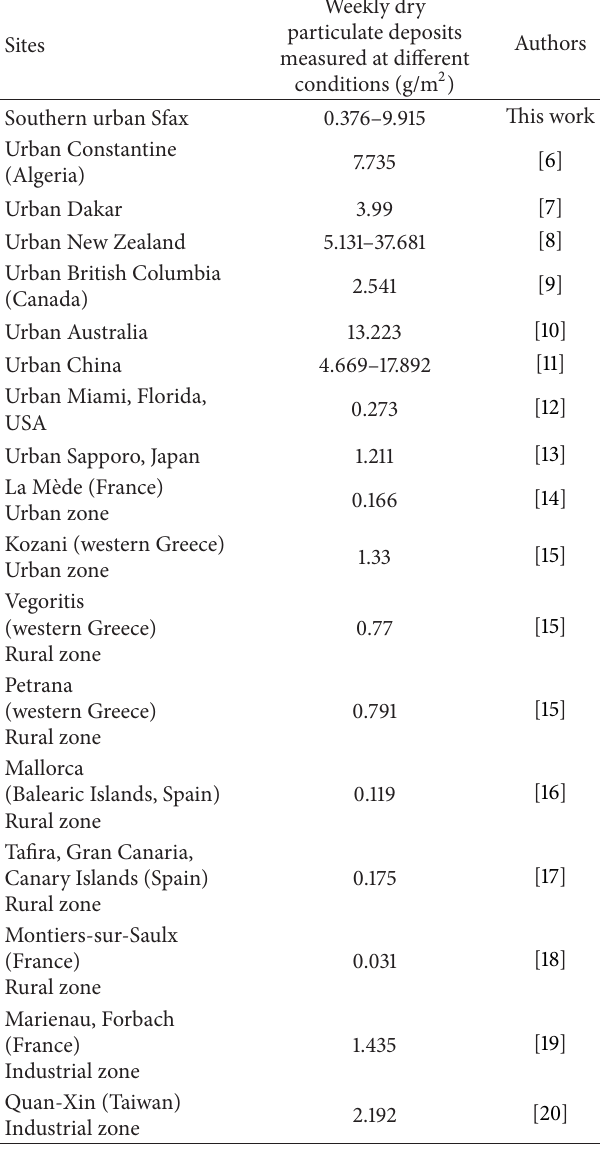
Table 2: Fluxes of particulate deposits measured at different conditions from several areas over the